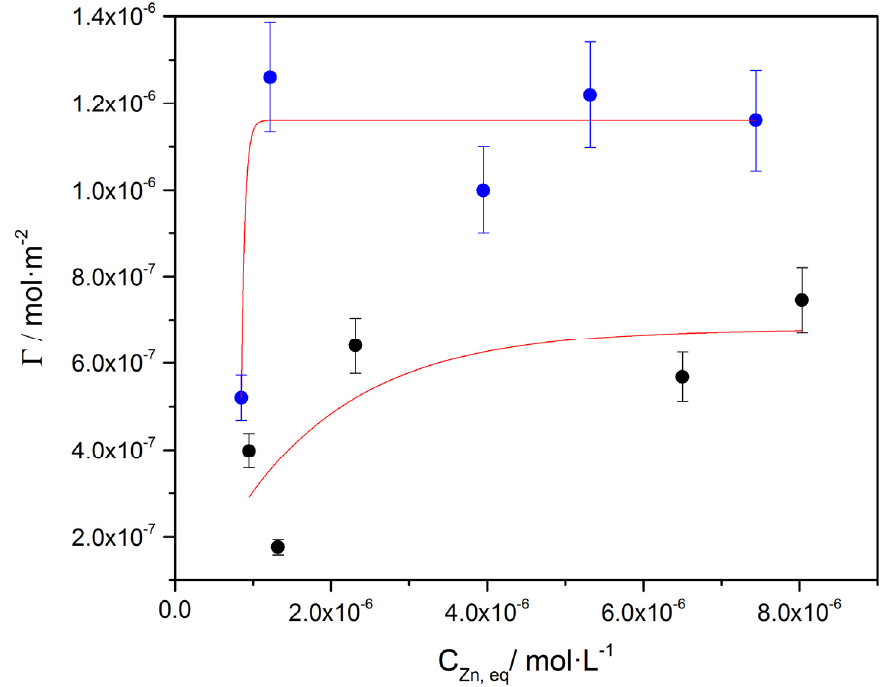
Figure 12. Total chlorophyll concentration in the supersaturated solutions as a function of time during the precipitation of calcium carbonate in the presence of 10 μ M of Zn ( ), Cd ( ), Ni ( ) and Cu ( ), in the presence of active A. obliquus culture under illumination; ( a ) SR calcite = 14.79; ( b ) SR calcite = 31.36; 25 °C, pH 8.50, 0.15 M of NaCl.